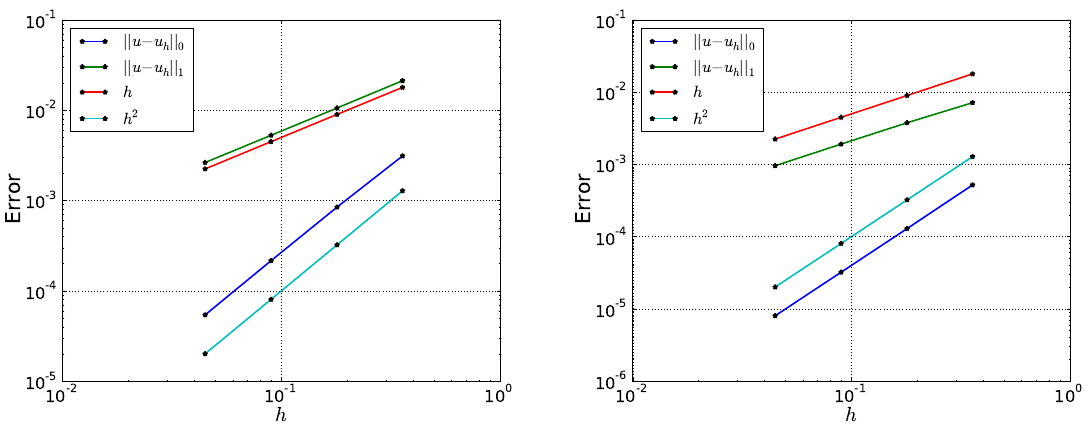
Fig. 8. k u − u h k 0 and k u − u h k 1 versus mesh size h (where u is the exact solution and u h is the numerical solution of Eq. 51), using